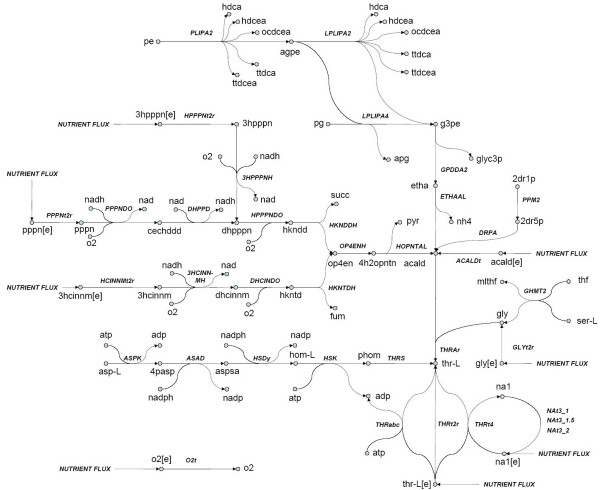
MCS uncover robust L-threonine biosynthesis subnetwork. 10,655 minimal cut sets discovered using our approach target L-threonine synthesis via this 41 reaction subnetwork of E. coli metabolism. None of these reactions are 1- or 2-essential for L-threonine production, though 7 participate in size 1 or 2 MCS for peptidoglycan and L-methionine production. Though many of these cut sets are complex (i.e. involve 7 or more reactions) they can be intuitively understood as simultaneous attacks on a few distinct pathways that converge on L-threonine (thr-L) synthesis. For ease of presentation, we omit water and proton in the reaction depictions. Please refer to Table 2 for explanation of metabolite and reaction abbreviations. Please refer to the text for further discussion.